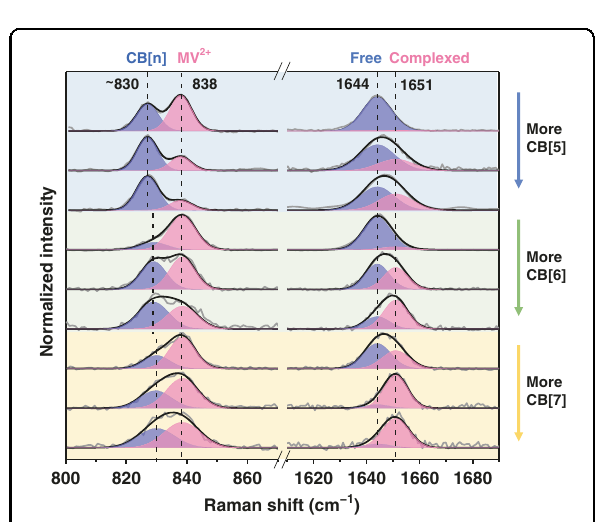
Fig. 5 CB[5]/CB[6]/CB[7] concentration-dependent SERS spectra obtained with 2.5 μ M MV 2 + 2I − . The concentrations of CB[5]/CB[6]/ CB[7] are 0.62 μ M, 1.25 μ M, and 2.5 μ M from top to